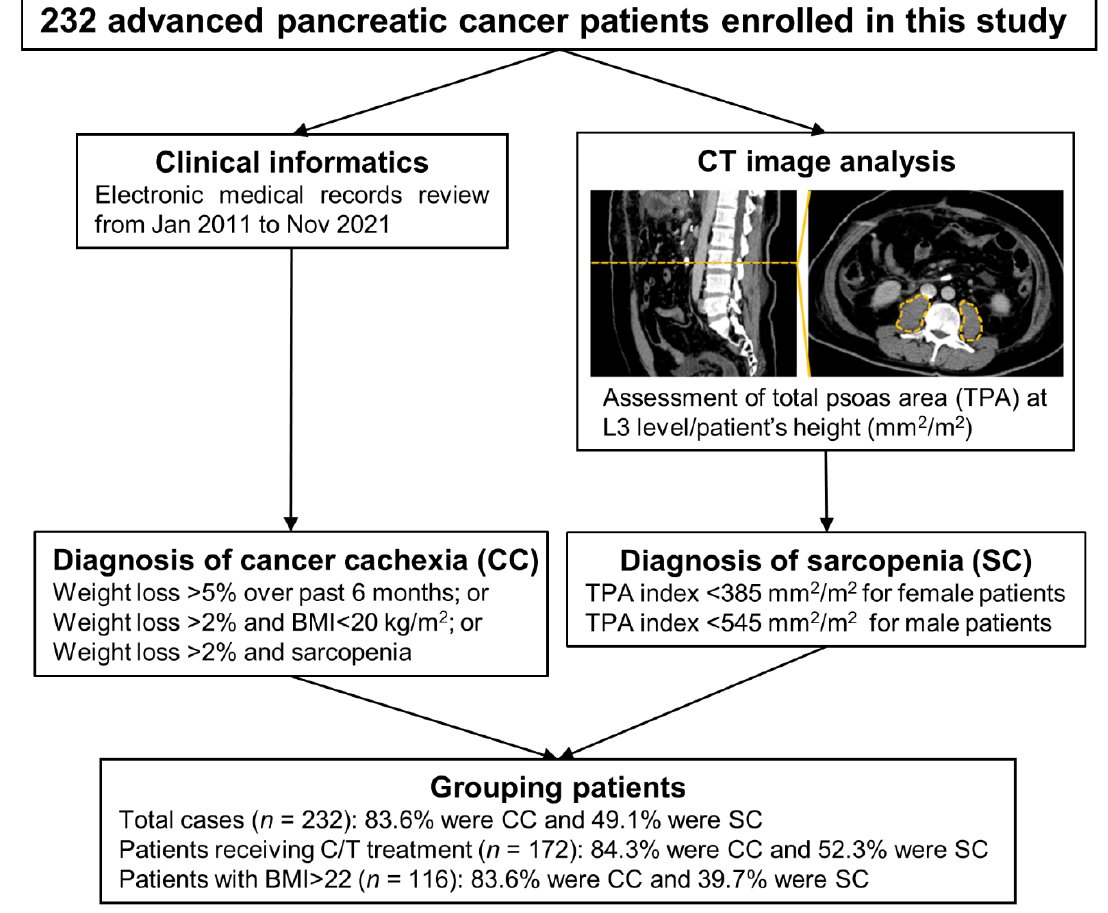
Figure 1. Study design flowchart illustrating the process of participant recruitment, data collection, and analysis throughout this study. CT, computed tomography; TPA, total psoas area; L3, the third lumbar vertebrae; CC, cancer cachexia; BMI, body mass index; SC, sarcopenia: C/T,